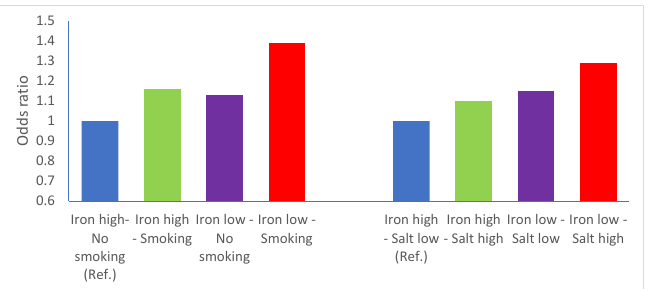
Figure 1. Interactions between iron and tobacco smoking and iron and salt intake — iron intake is categorized above (reference category) vs. below median intake. Odds ratios adjusted for study, sex, age, smoking status, socioeconomic status, calorie intake, salt intake. Ref = reference